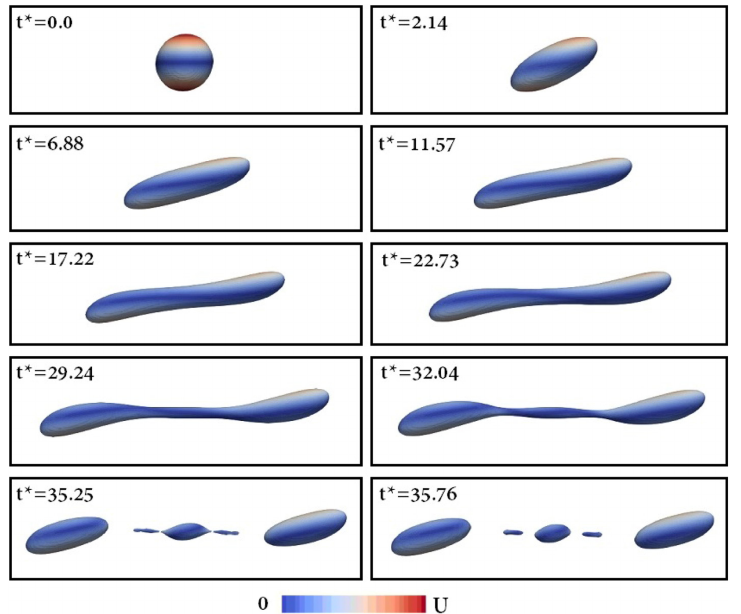
Figure 1. Temporal evolution of a 3D droplet shape under a simple shear flow. Reprinted from [4] with permission from